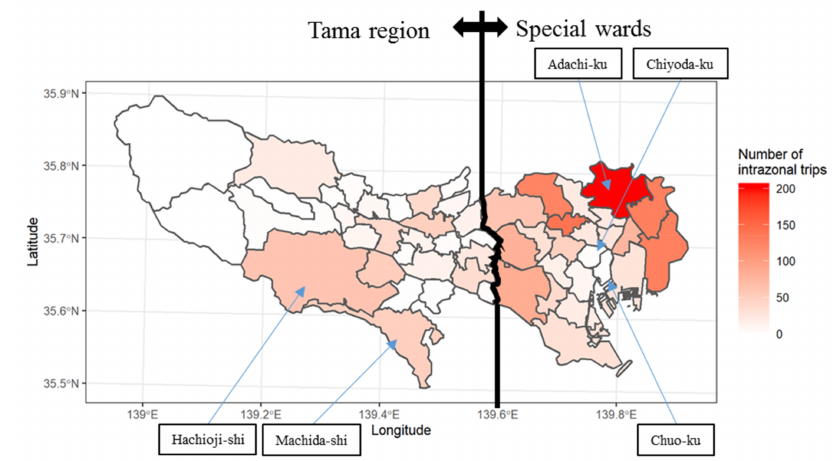
Figure 5. Spatial distribution of intrazonal criminal